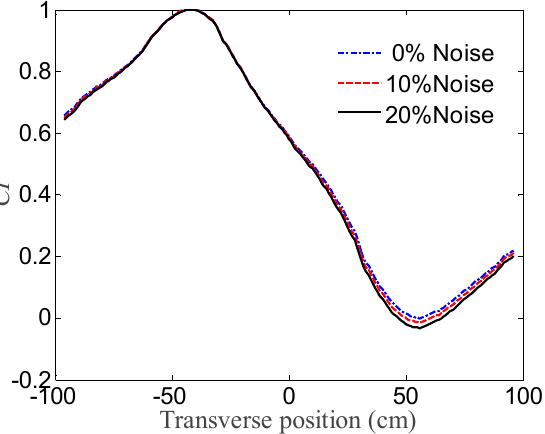
Figure 7. The variation curve of the CI index relative to the transverse position.